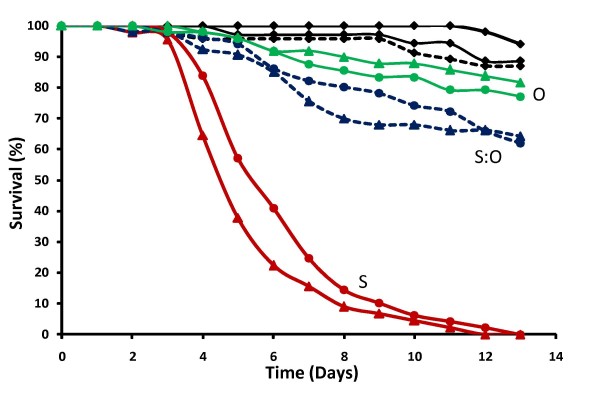
Effect of formulation. Cumulative daily proportional survival of female An. gambiae s.s. exposed for 6 hrs to cardboard papers manually coated with M. anisopliae spores (triangles) or B. bassiana spores (circles) formulated in Shellsol solvent (S, red), a 1:1 Shellsol/Ondina mix (S:O, blue) or Ondina oil (O, green). For each formulation, one group of 50 females was exposed to 3 × 1011 viable spores/m2. Corresponding control groups (black) were exposed to the solvents only.